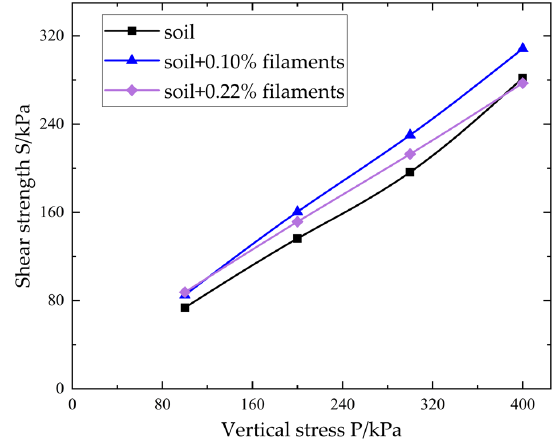
Figure 4. Shear strength curve.